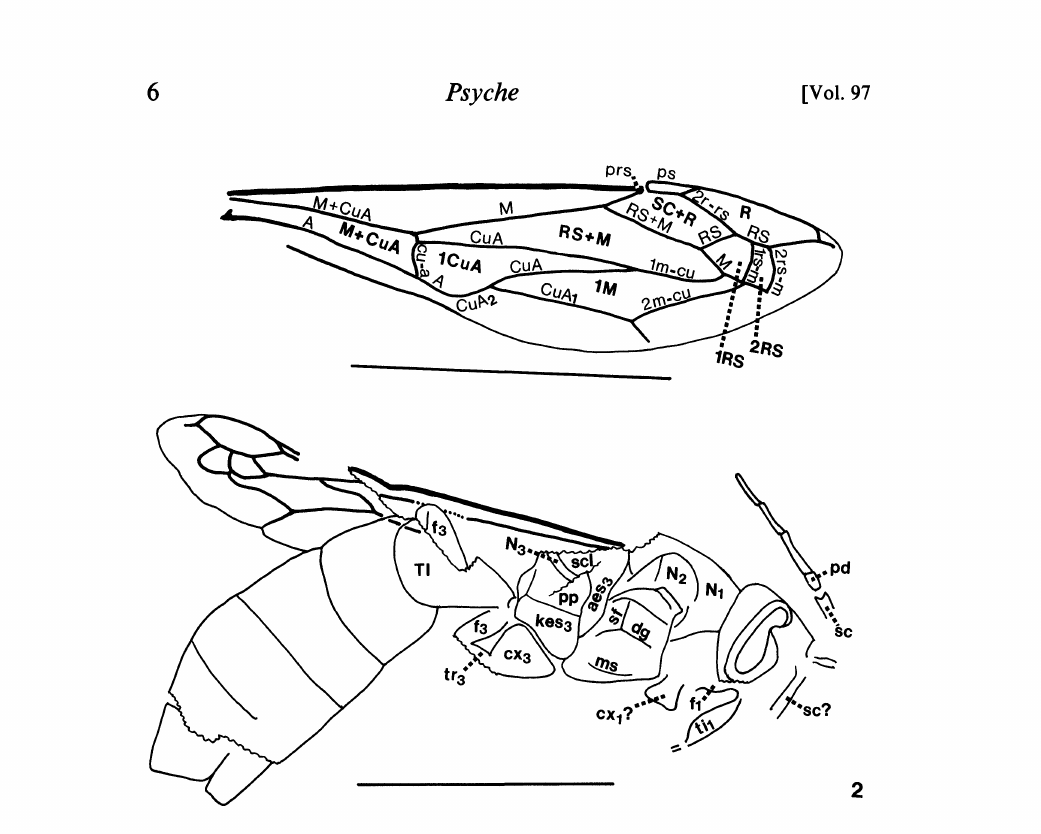
Fig. 1. Curiosivespa curiosa Rasnitsyn, holotype. Abbreviations for veins are light and placed along veins, those for cells are boldface and placed at cell center. Cells: R-marginal; SC+R, IRS and 2RS-first, second and third submarginals, respec- tively; RS+M and lM-first and second discals, respectively; M+CuA-subbasal; 1CuA-first subdiscal; prs-prestigma; ps-pterostigma. Scale bar in all Figures 5 mm. Fig. 2. Curiosivespa curiosa Rasnitsyn, specimen No. 2783/261. aes3-metanepis- ternum; cx-forecoxa; cx3-hindcoxa; dg-dorsal groove; f-forefemur; fa-hindfemur; kes3-metakatepisternum; ms-mesopleural signum; N-pronotum; N2-scutum; N3- metanotum; pd-pedicel; pp-propodeum; sc-scape; scl-scutellum; sf-scrobal furrow; TI-first metasomal tergum; ti]-foretibia;